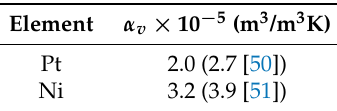
Table 1. Comparison of volumetric expansion coefficients ( α v ) obtained from the present ReaxFF MD simulations, and reported from literature (in